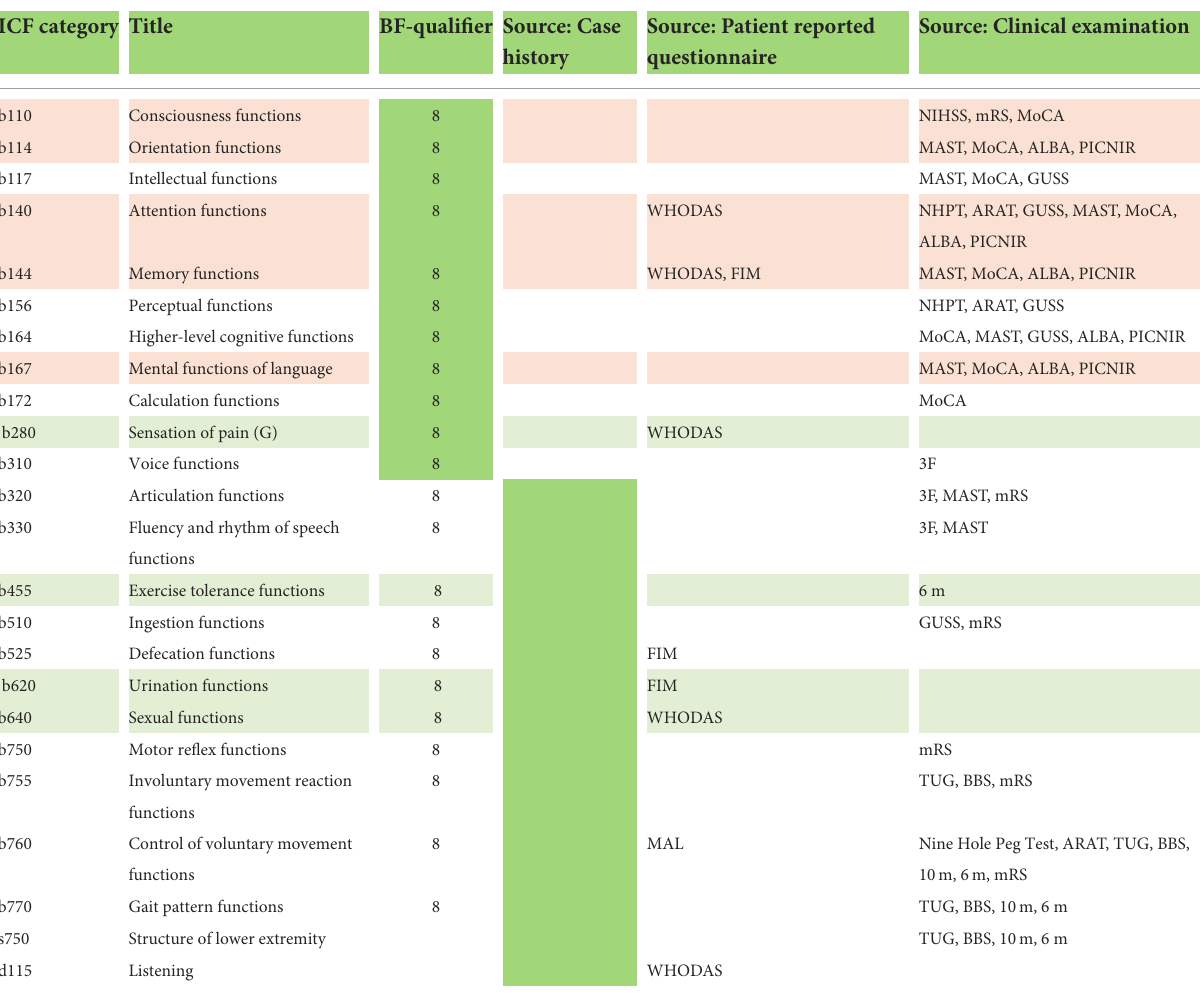
TABLE 4 An example of linking of clinical test results to the